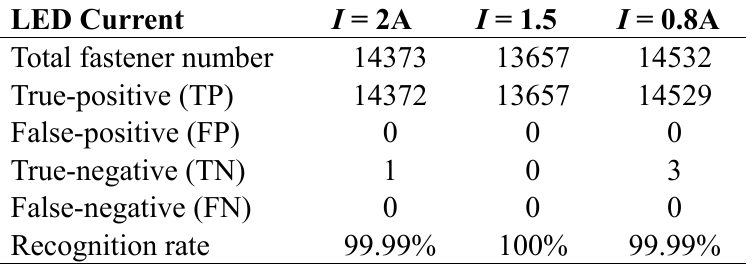
Table 7. Recognition rate of practical images using our